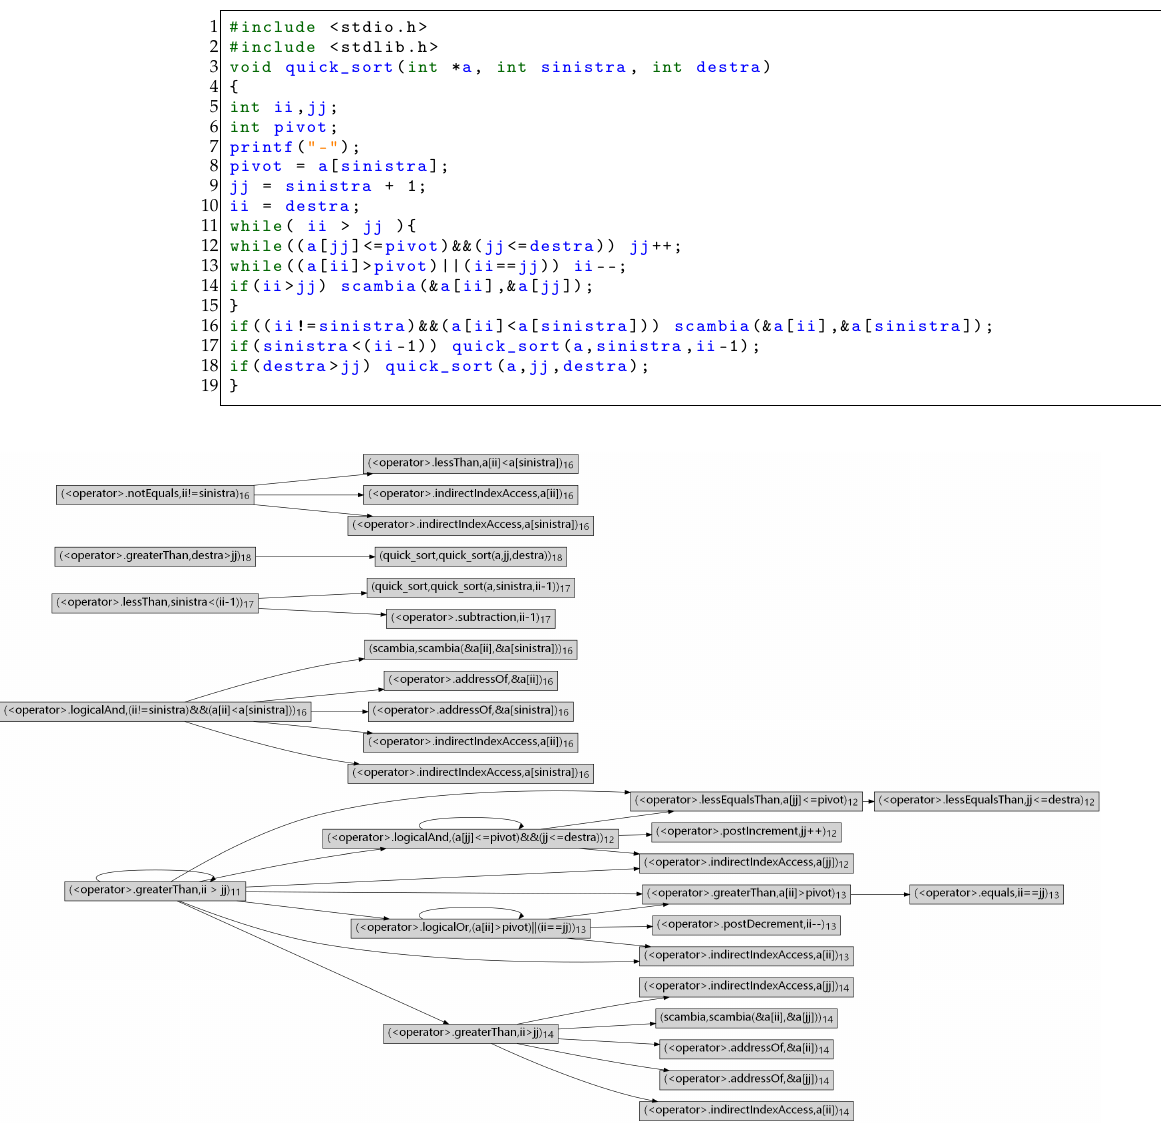
Figure A1. The initial control dependency graph of quick